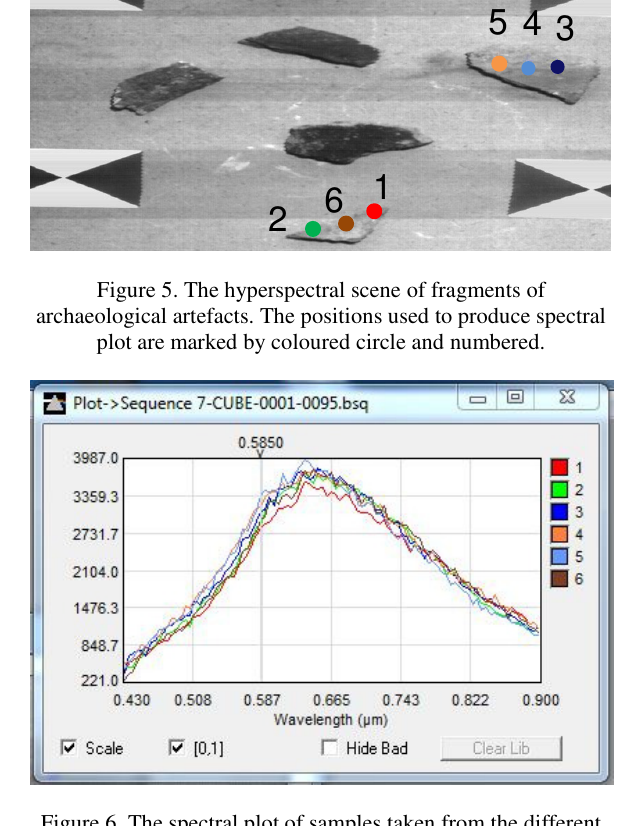
Figure 6. The spectral plot of samples taken from the different places and different fragments that reside to the same artefact. The number on spectral plot corresponds to the number of sample taken (Figure 5).